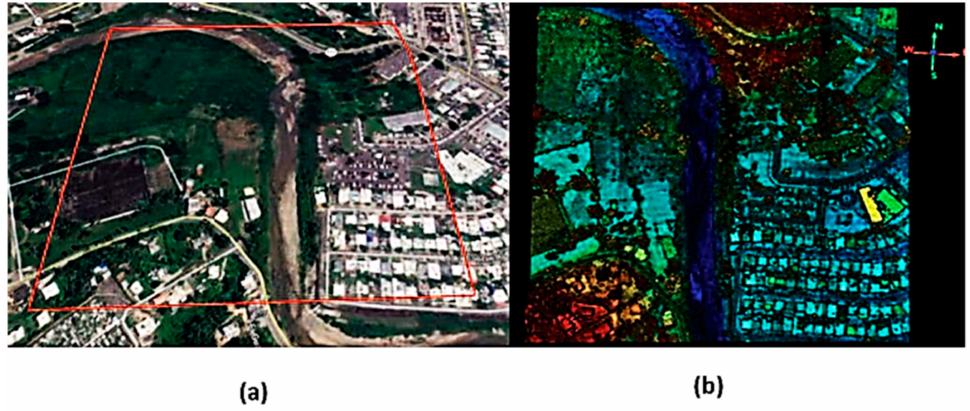
Figure 6. ( a ) Google Earth image of an area in Utuado PR with LiDAR data tile outlined in red and ( b ) the corresponding LiDAR